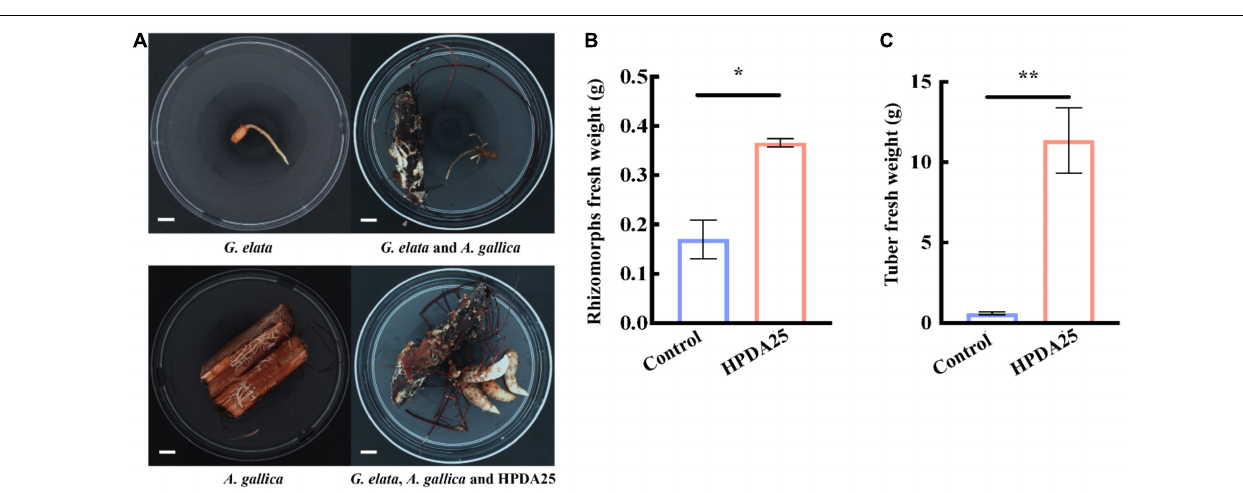
FIGURE 4 | HPDA25 promoted both A. gallica and G. elata growth. (A) HPDA25, A. gallica, and G. elata growth. (B) HPDA25 increased fresh weight of A. gallica rhizomorphs. (C) HPDA25 increased fresh weight of G. elata . Control, G. elata co-cultured with A. gallica . Data are shown as means ± SE. * P < 0.05; ** P <